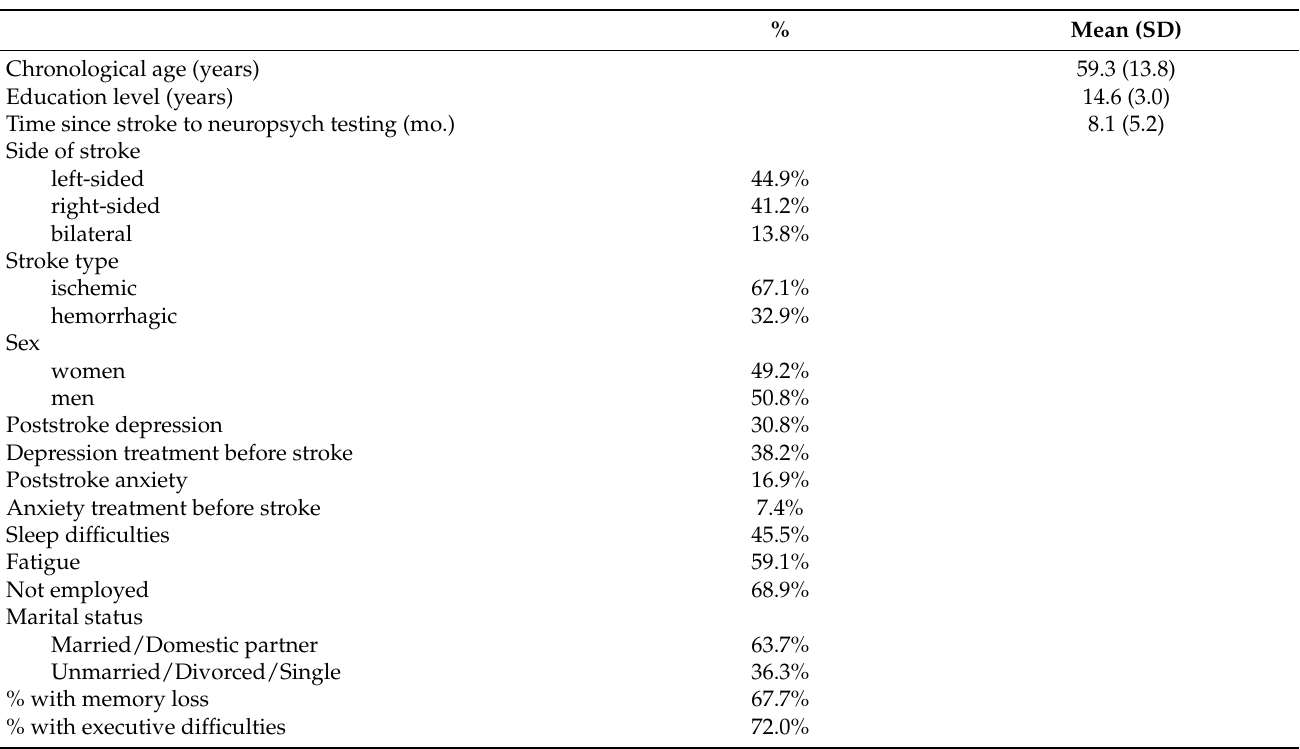
Table 1. List of Demographic, Stroke, Psychiatric, Psychosocial, and Cognitive Characteristics of the Sample, N = 325.